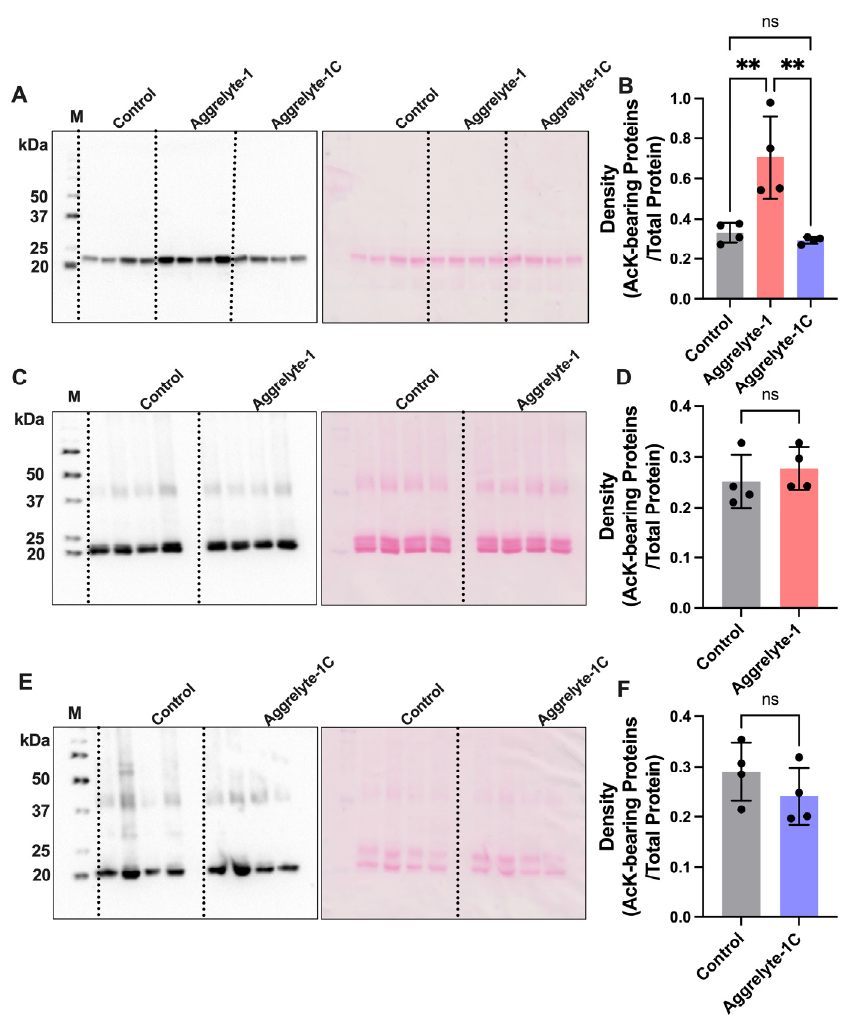
Figure 6. WS from aggrelyte-1 treated lenses contained higher levels of AcK. The levels of AcK- bearing proteins in WS from mouse ( A , B ) and human lenses treated with aggrelyte-1 ( C , D ) or aggrelyte-1C ( E , F ) were determined by Western blot analysis. Twenty micrograms of protein from each sample were used for Western blotting. Ponceau S-stained membranes showed protein loading. Densitometric plots represent the mean ± S.D. of n = 4 measurements. M = molecular weight markers. ** p < 0.01, ns = not significant.